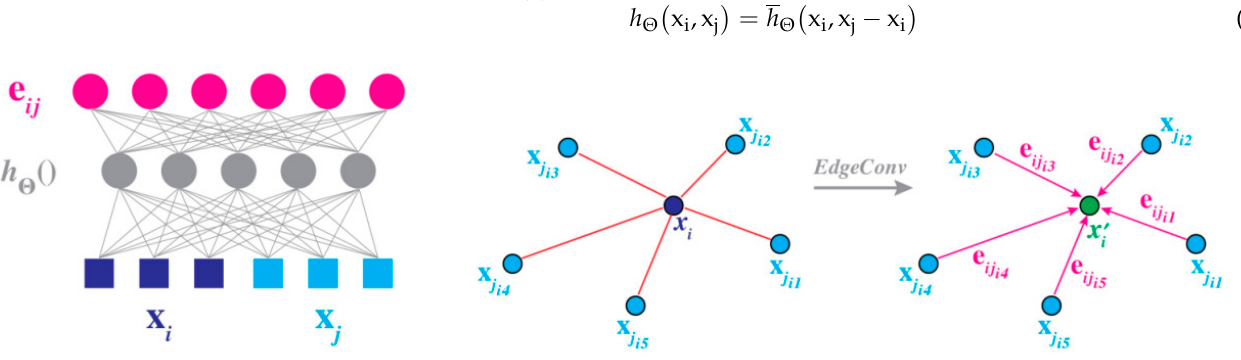
Figure 3. Schematic diagram of EdgeConv local feature extraction. This makes the local and global features of the point cloud better connected, where x j − x i is used to capture neighborhood information, and x i is used to represent the location of local features in the global. After the point cloud data flow into the network, each point is calculated by the k-NN algorithm using the Euclidean distance in three-dimensional space to calculate the nearest k neighboring points. The aggregation operation used when aggregating features is shown in Formula (4), which can be implemented as a shared MLP. The parameter of the neural network is Θ = ( θ 1 , . . . , θ M , φ 1 , . . . , φ M ) . The local characteristics of each point are shown in Formula (5).